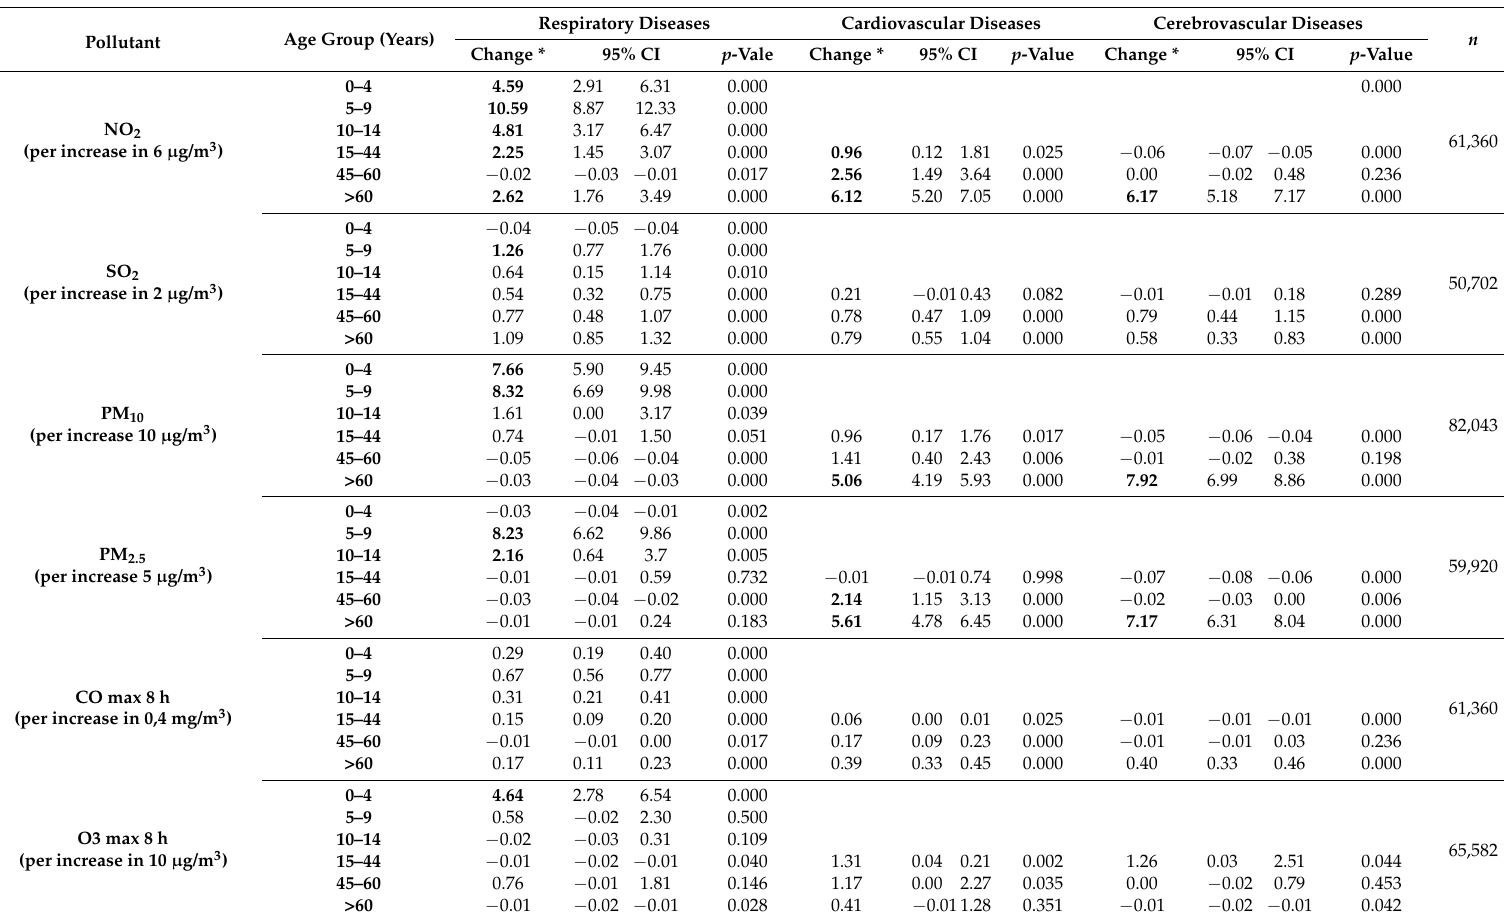
Table 3. Estimates of the effect on the general population in terms of respiratory, cardiovascular, and cerebrovascular diseases, by type of pollutant and age group, Colombia,